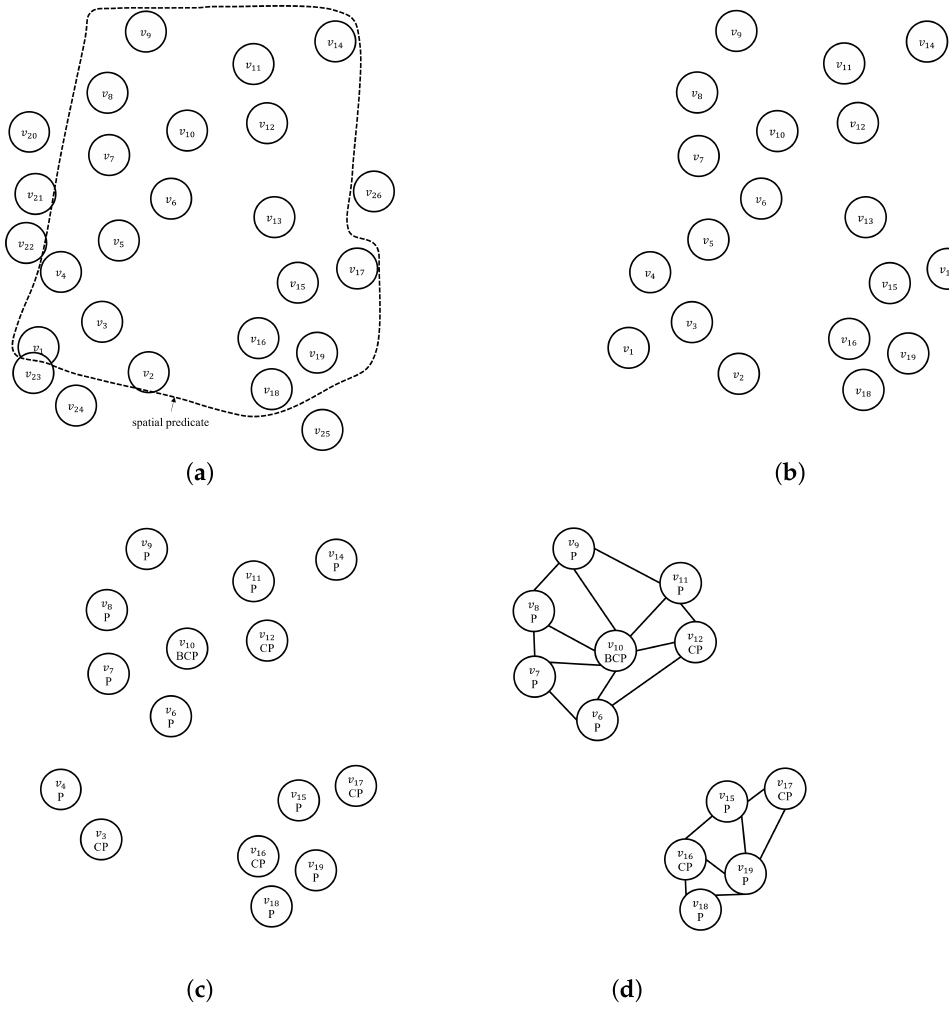
Figure 3. An example of SpatialFirst DBSCAN. ( a ) initial state and spatial predicate; ( b ) after spatialSelection ; ( c ) after deepSelection ( dp = ‘person’); ( d ) after constructNNGGraph ( k = 5). and density